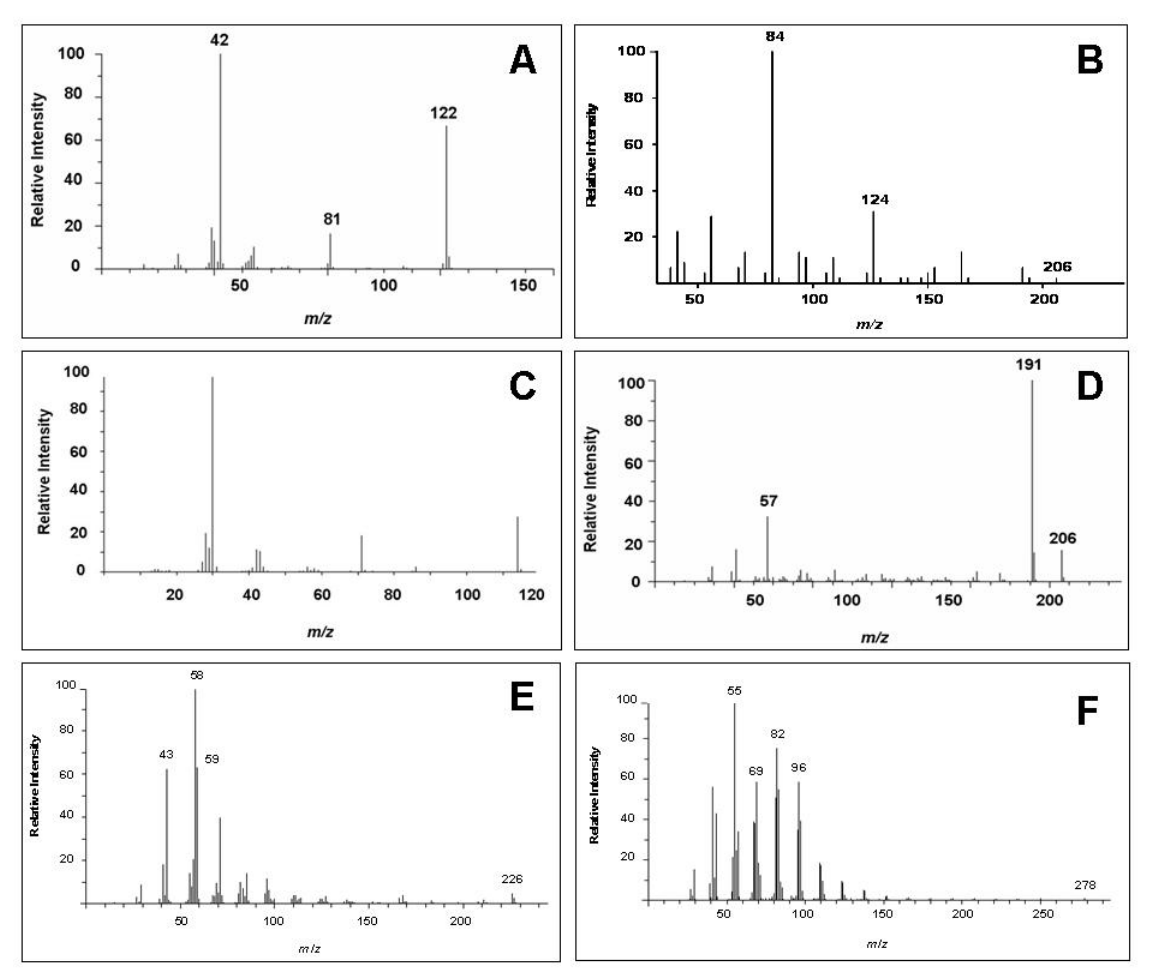
Figure 4. Mass spectra (70 eV) of ( A ) trimethyl pyrazine with base peaks at m/z 42 and 81; ( B ) 2,6,10-trimethylundecan-2,9-dien-4-one with fragments at m/z 84 and 124; ( C ) 2,5-piperazinedione with characteristic fragments at m/z 30, 114, 71 and 28; ( D ) phenol-2,4-bis (1,1 dimethylethyl) with mass spectral fragments at m/z 191 and 57; ( E ) pentadecan-2-one with the spectral fragments at m/z 58, 59 and 43, and ( F ) the unknown compound with the probable chemical formula C